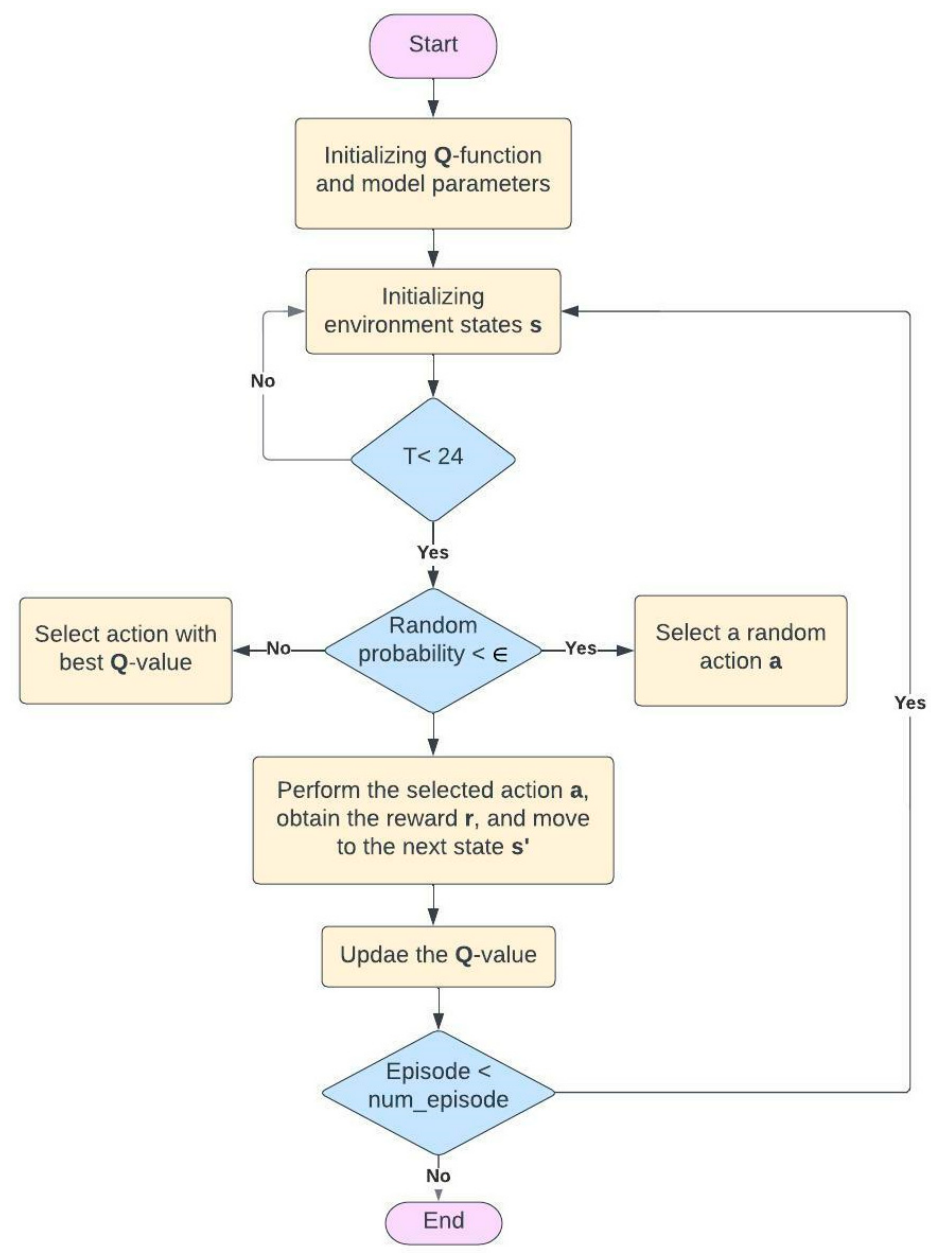
Figure 5. DQN agent implementation flowchart.